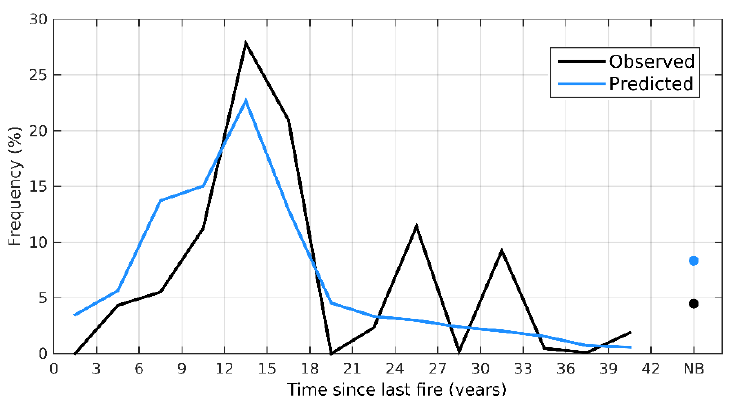
Table 3. Total simulated burned area for the 40-year period, and annual average decrease in esti- mated burned area (ha), when compared with the BAU scenario (inside brackets).